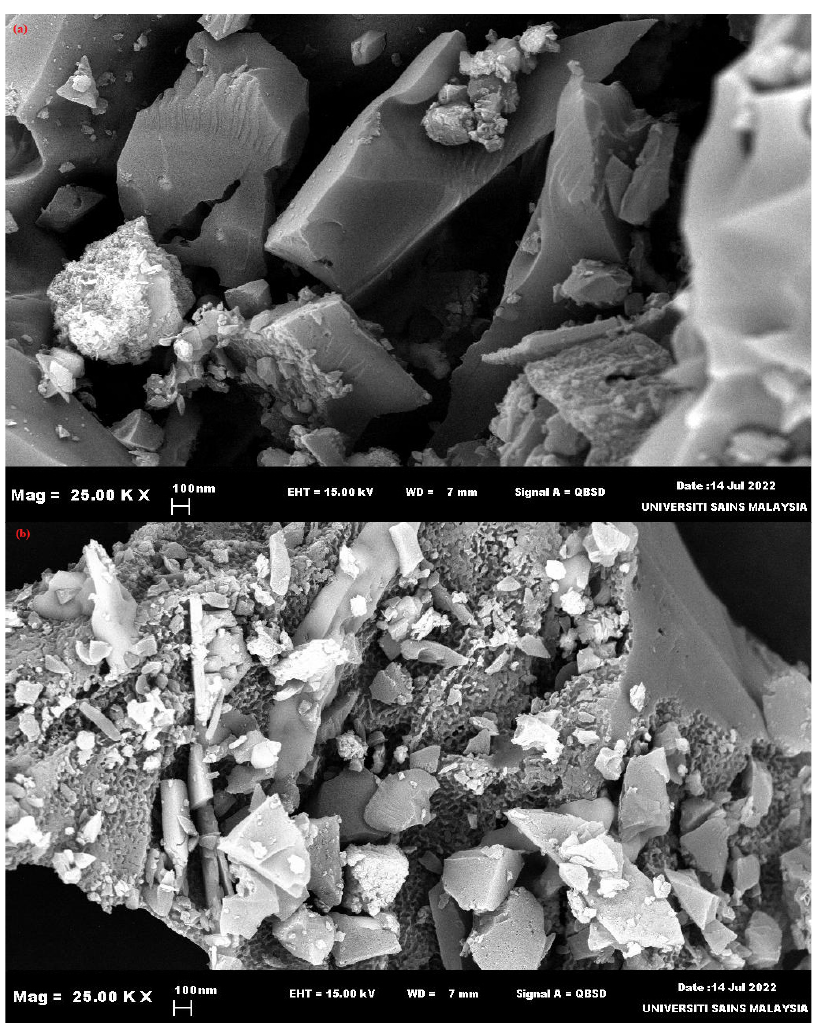
Figure 2. Scanning electron micrographs of pineapple fruit peel biochar ( a ) prior to ( b ) after PB dye uptake.